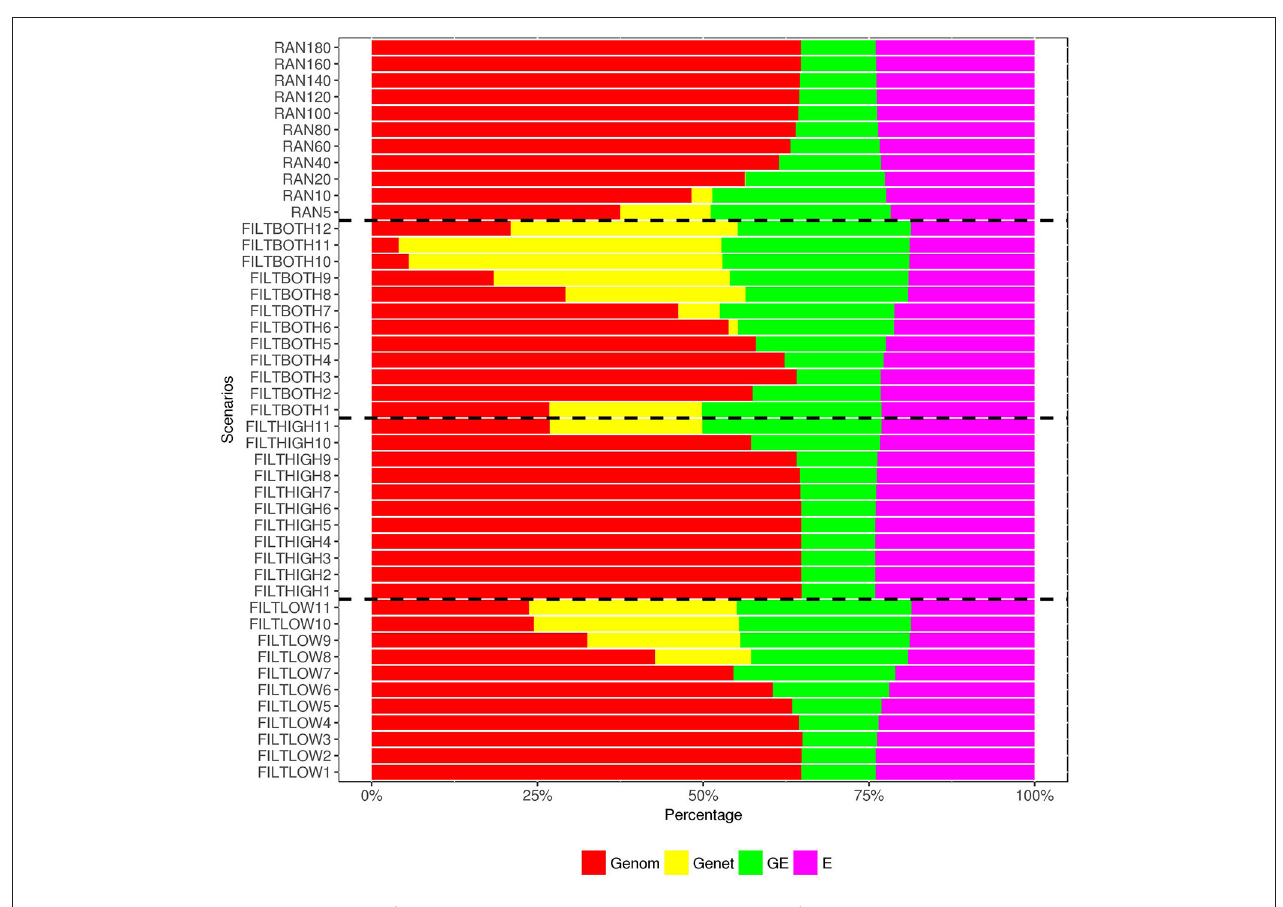
FIGURE 7 | Percentage of variance components 1 over the total phenotypic variance for heading date. 1 Genom, Additive genomic variance; Gene, Residual genetic variance; GE, family × sowing year × location × management variance; E, residual environment